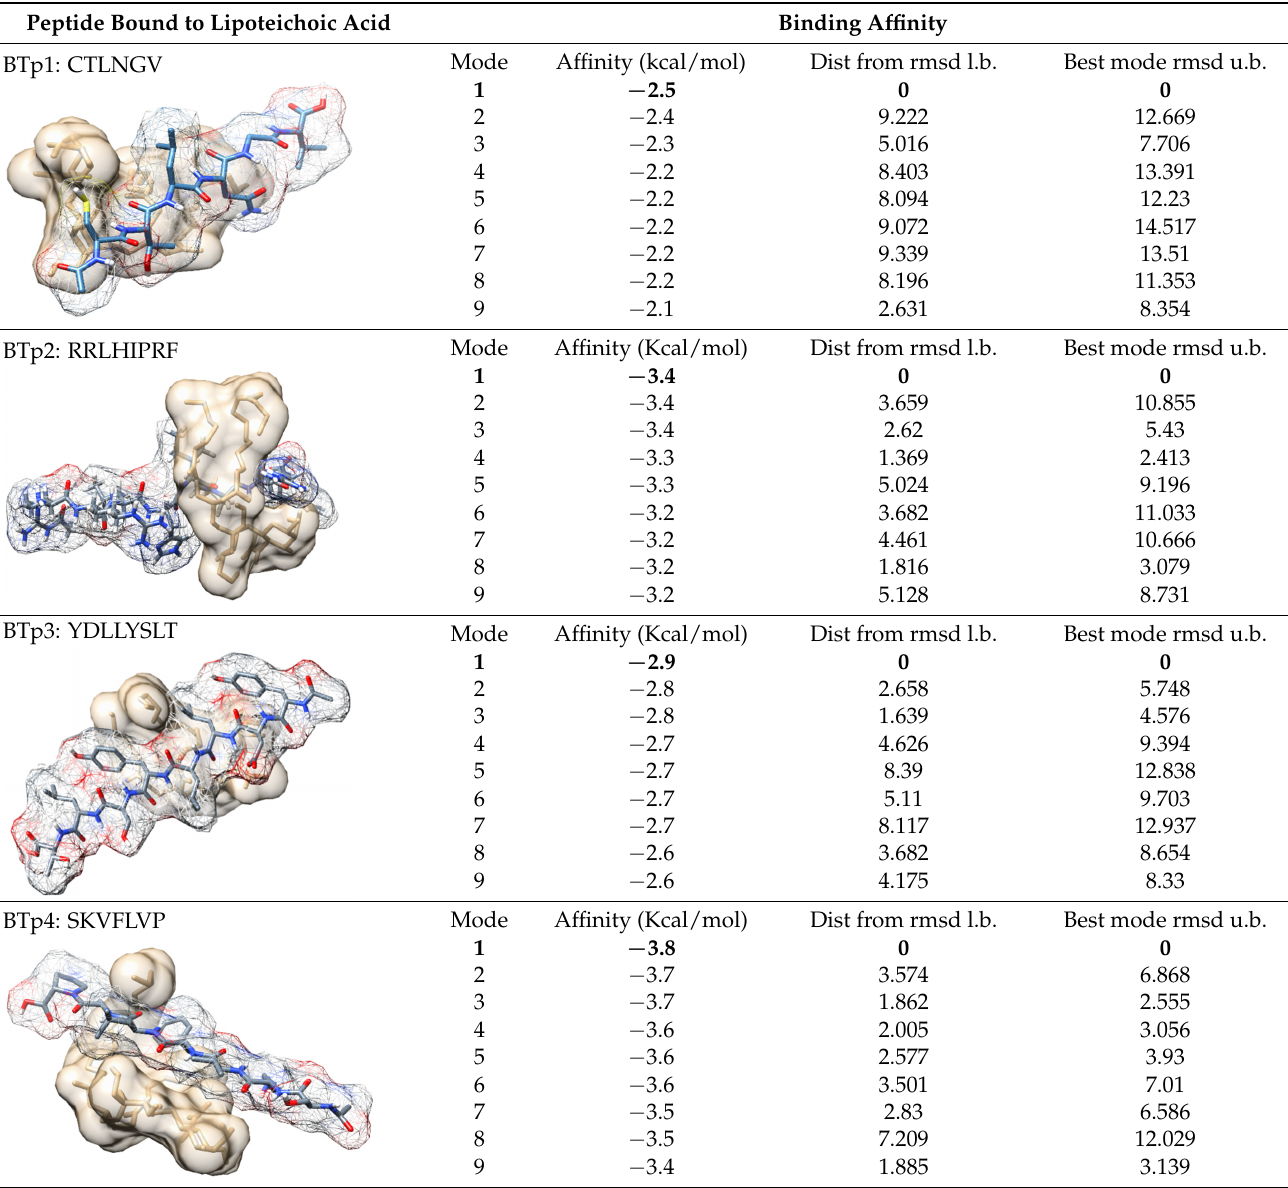
Table 1. Binding affinity of the top nine poses of four novel peptides to lipoteichoic acid. Peptide Bound to Lipoteichoic Acid Binding Affinity BTp1: CTLNGV